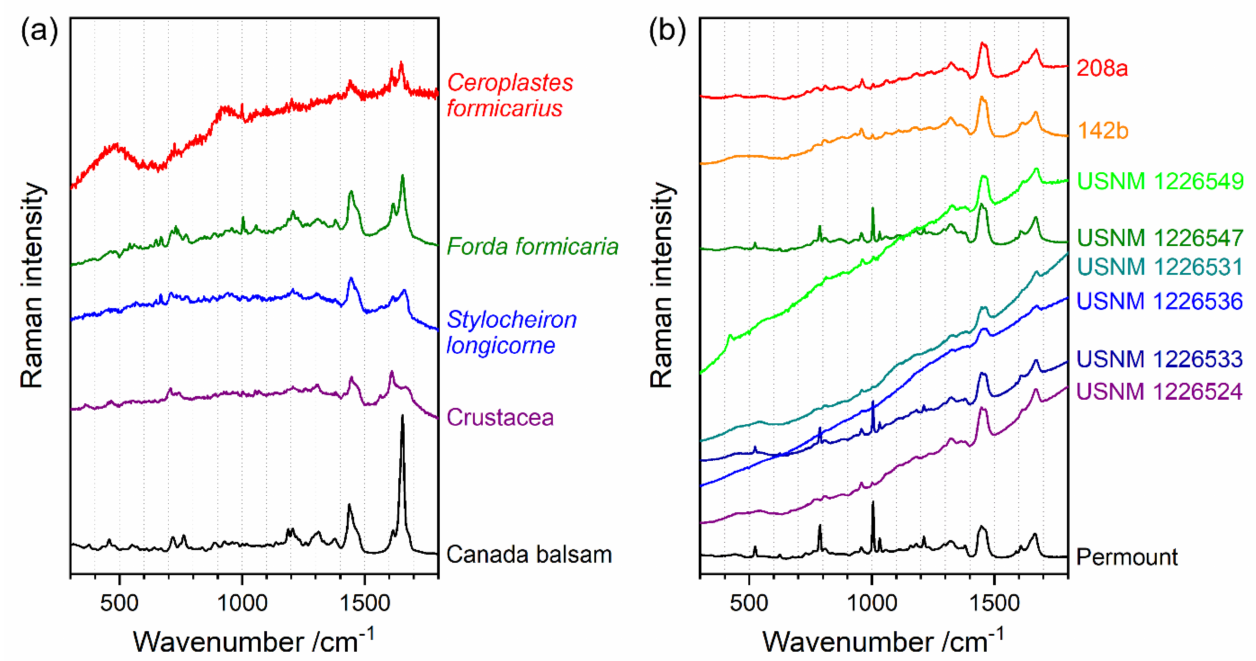
Figure 1. Identification of mounting media: ( a ) Canada balsam, and ( b ) Permount TM ; USNM followed by catalogue number of the United States National Museum, Washington, D.C., Smithsonian Institution, Cateria gerlachi (Kinorhyncha); Sorex araneus (Mammalia), # 142b and Ctenodactylus gundi (Mammalia), # 208a, numbers refer to the Hubrecht Collection. The black traces at the bottom represent Raman reference spectra of pure mounting